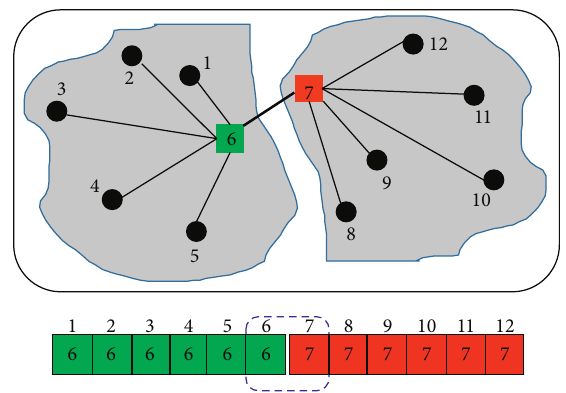
Figure 2: Solution